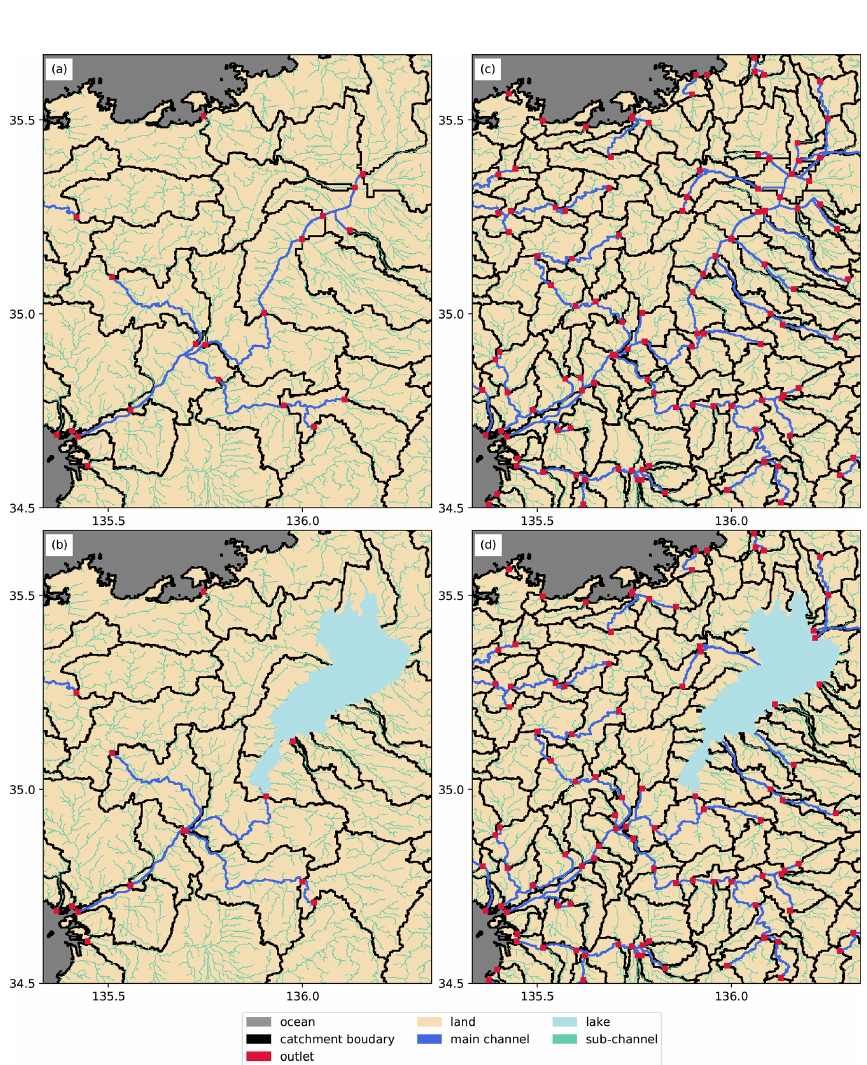
Figure 1. Example of the upscaled river–lake network dataset. The panels show results under four different configurations for Lake Biwa and Yodo River basin in Japan: (a) 15arcmin without lakes, (b) 15arcmin with lakes, (c) 6arcmin without lakes, and (d) 6arcmin with